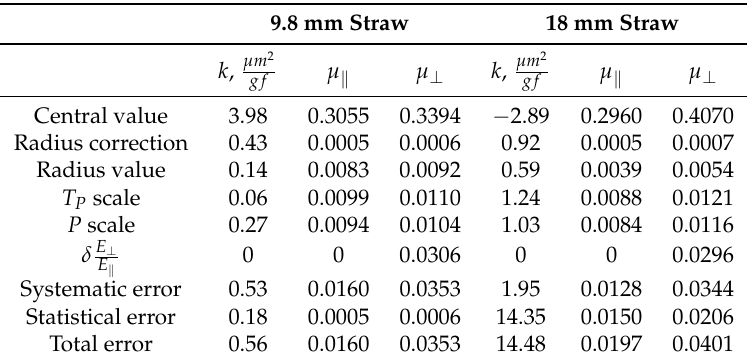
Table 2. Poisson’s ratio measurement